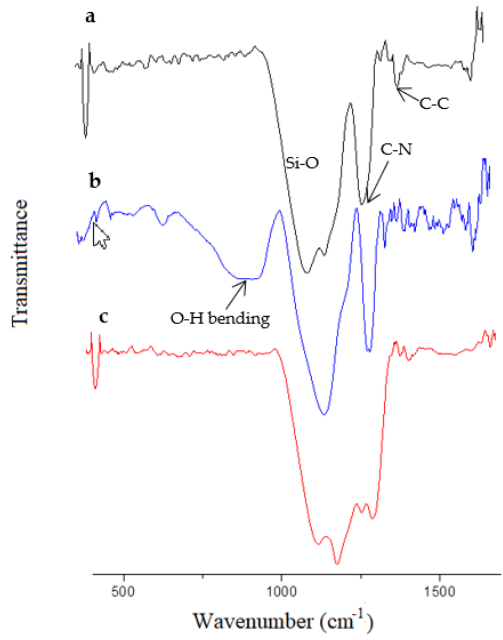
Figure 3. Normalized FT-IR spectra of ( a ) NAM-APTS, ( b ) NAM-APTS-EDTA, and ( c ) NAM- CuO/Cu 2 O. All spectra were obtained using hydroxylated NAM as a background.